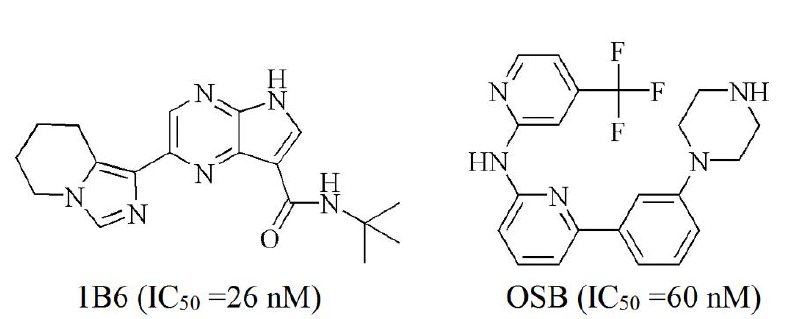
Figure 1. Structures of 1B6 and